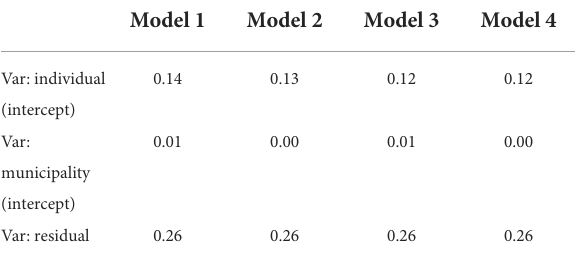
TABLE 5 Multilevel linear regression models for